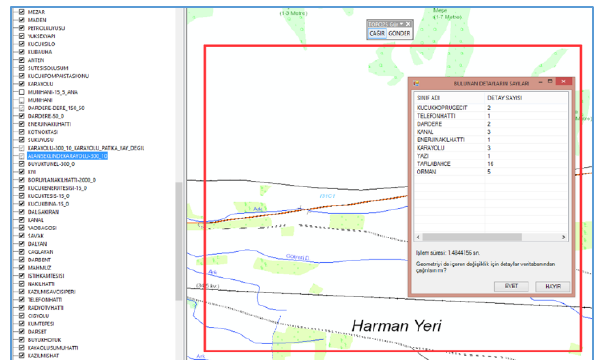
Figure 8. Number of features in selected